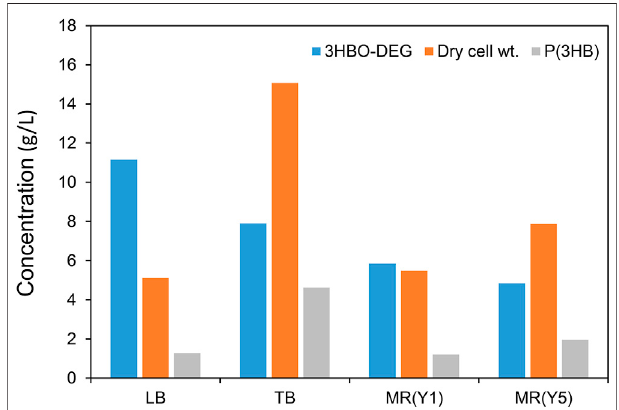
FIGURE3| Effectofculturemediaon3HBO-DEG secretioninthebatch culturewitha250-mlminijarfermenter. Recombinant E.coli BW25113 Δ adhE harboring the pGEM- phaRC YB4 AB was cultured in a 100 ml culture medium supplemented with 40 g/L glucose and 50 g/L DEG at 30 ° C, 1 vvm, 600 rpm, pH uncontrolled for 48 h.